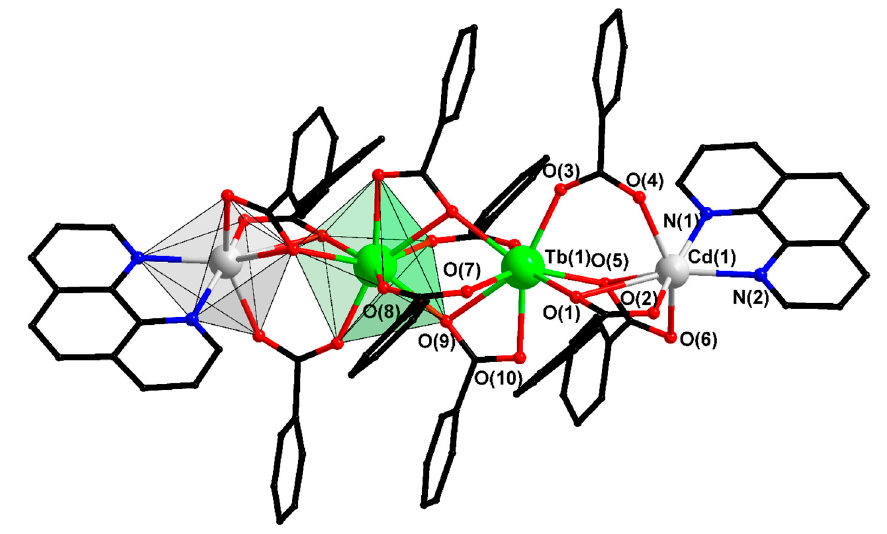
Figure 2. Structure of complex V. Hydrogen and fluorine atoms are omitted.